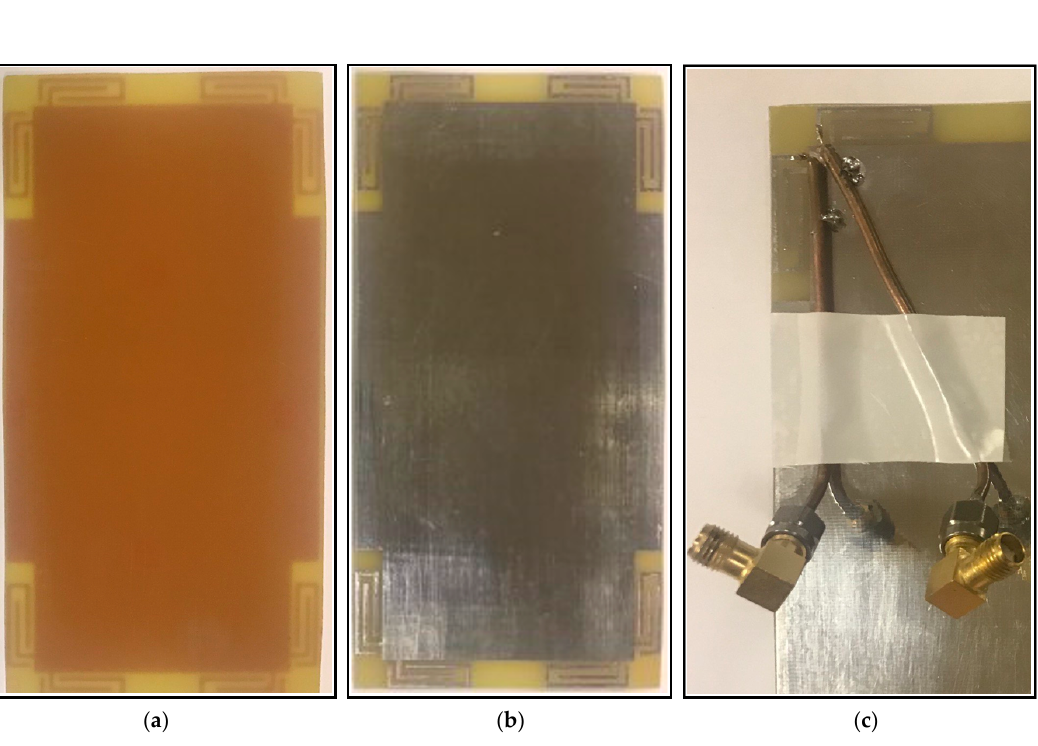
Figure 10. ( a ) Front and ( b ) back views, and ( c ) feeding mechanism of the fabricated sample.